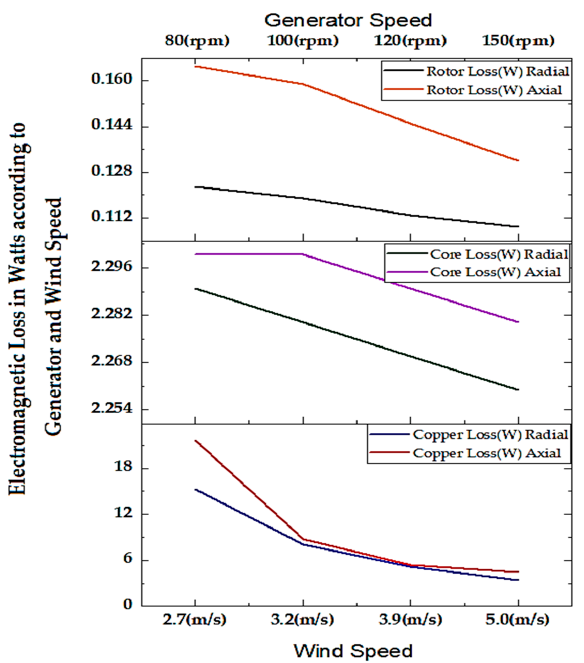
Figure 12. Electromagnetic loss according to generator speed [33]. R: Radial Flux PM Generator, A: Axial Flux PM Generator.